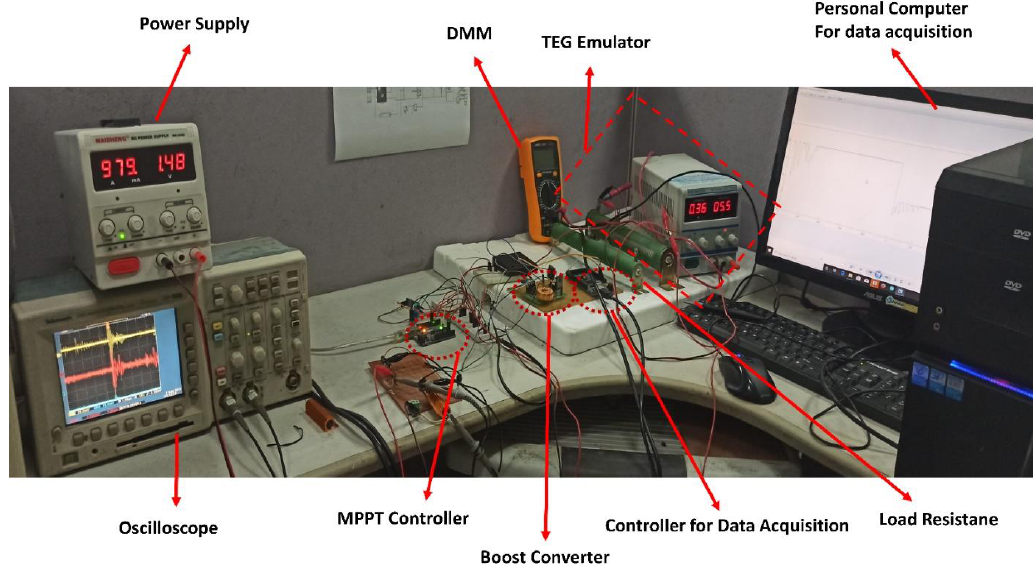
Figure 24. Hardware setup for MPPT control of TEG system.